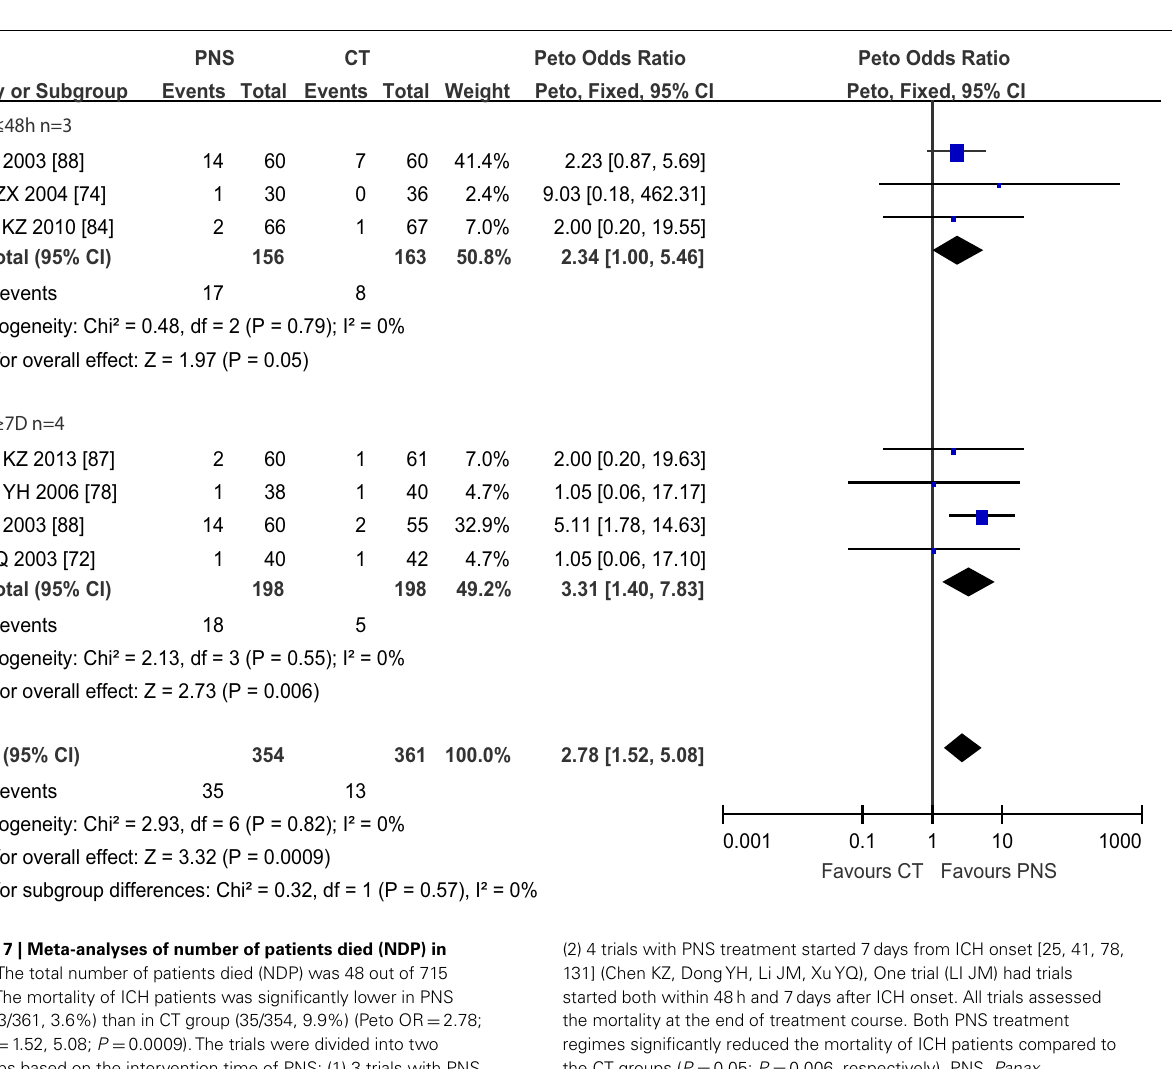
ICH onset (Peto OR = 2.34; 95% CI = 1.00, 5.46; P = 0.05),